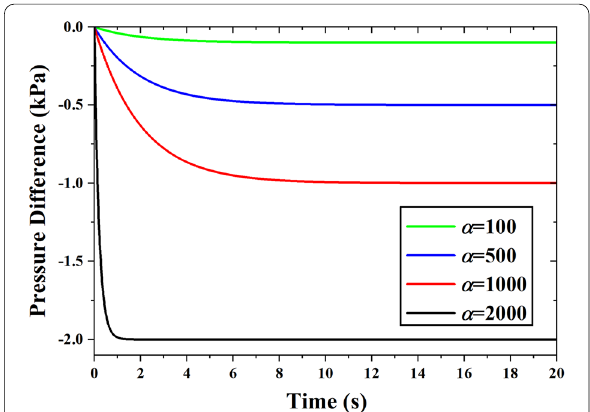
Figure 6 Relationship of λ and pressure